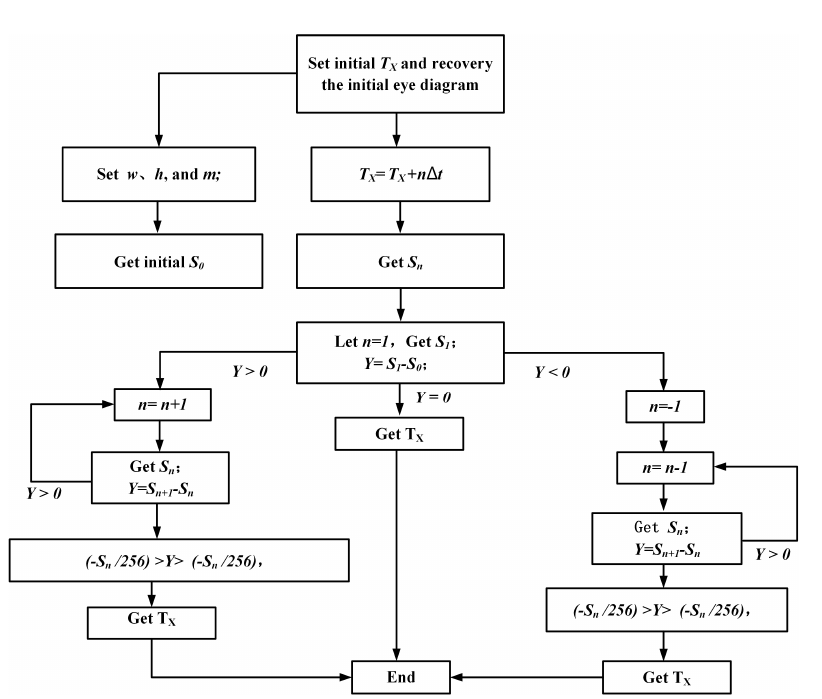
Figure 4. Eye diagram recovery algorithm.